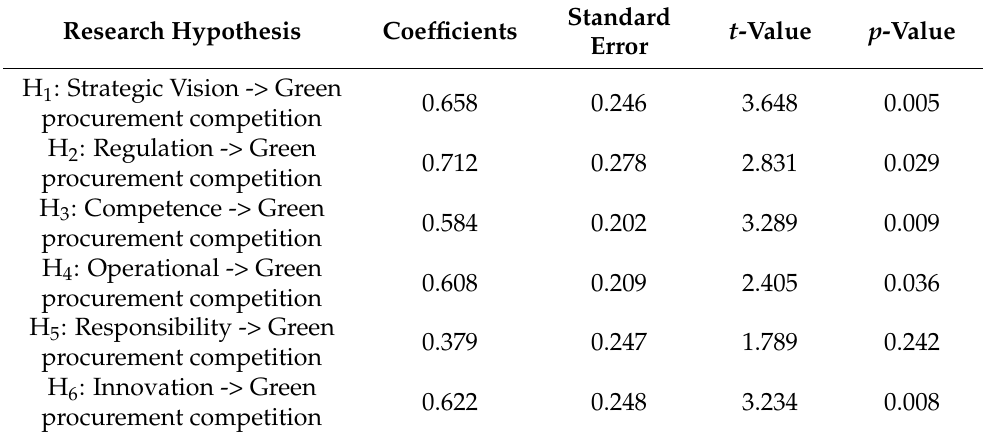
Table 5. Results of statistical hypotheses